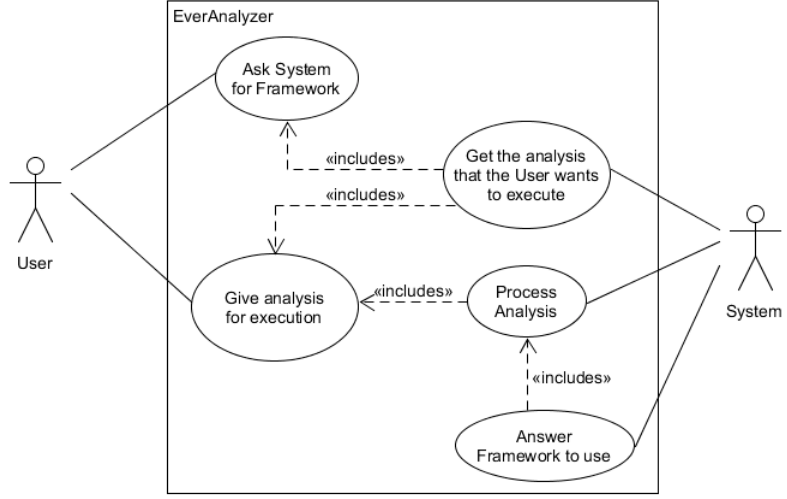
Figure 11. Use Case diagram of EverAnalyzer Objectives #5 and #6.